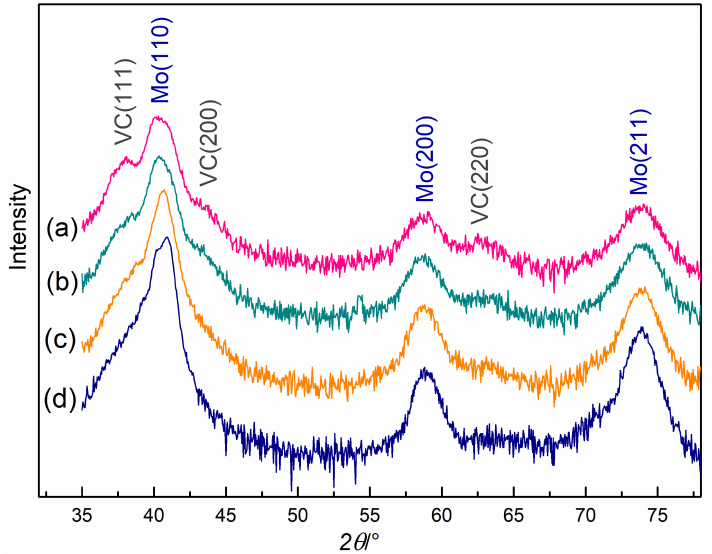
Figure 2. GIXRD spectra of Mo/VC multilayers: (a) η Mo/VC = 6:4, (b) η Mo/VC = 7:3, (c) η Mo/VC = 8:2, (d) η Mo/VC = 9:1.